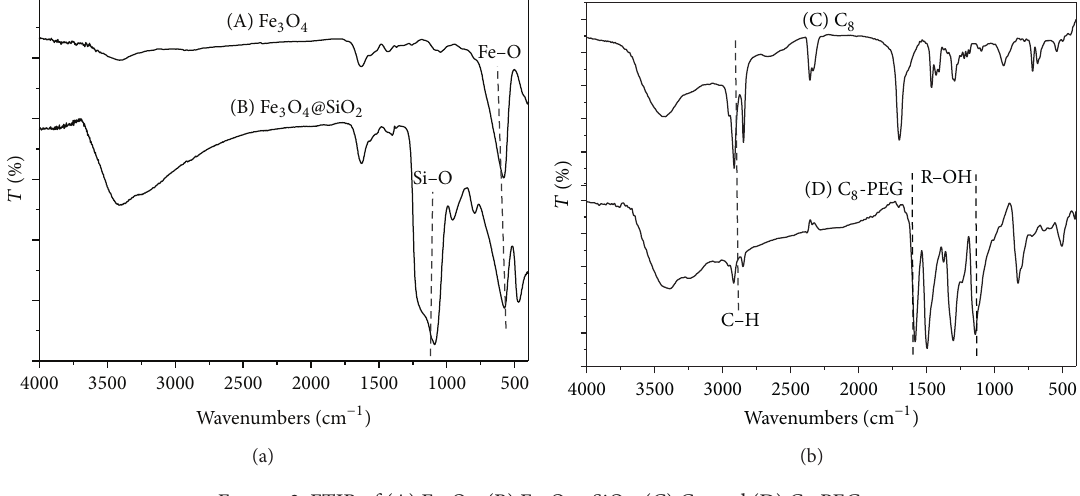
Figure 2: FTIR of (A) Fe 3 O 4 , (B) Fe 3 O 4 @SiO 2 , (C) C 8 , and (D) C 8 -PEG.